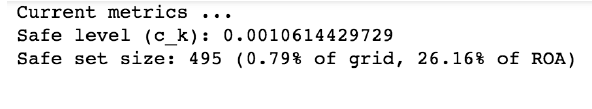
Figure 8: Safe level and safe set size for AS equilibrium with maximum state variables and control input defined in